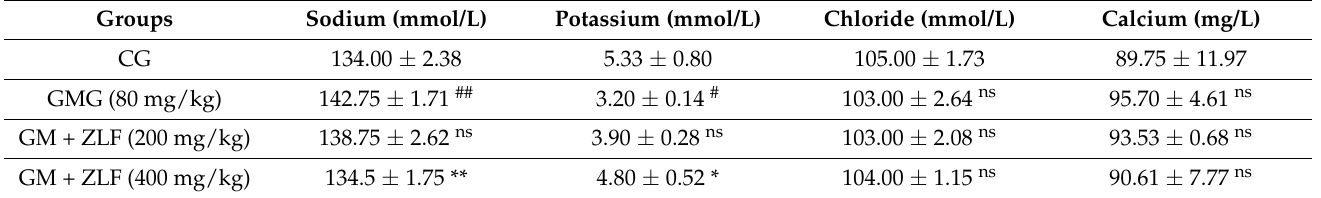
Table 3. Effect of ZLF’s extract on serum sodium, potassium, chloride, and calcium levels in rats exposed to GM.